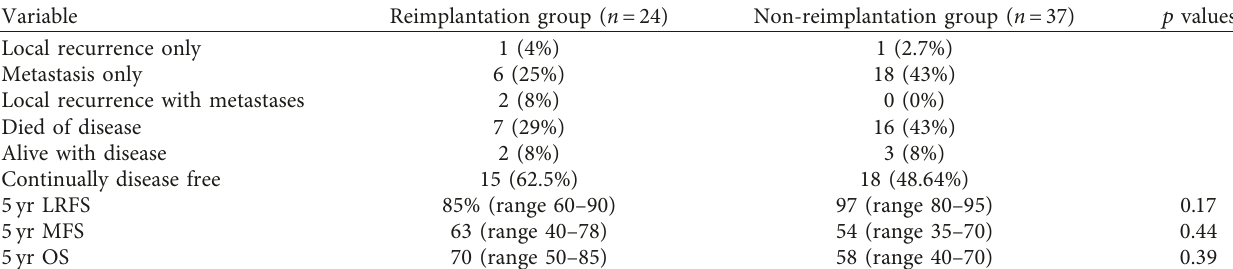
Table 2: Summary of outcome variables in the reimplantation and the non-reimplantation group.